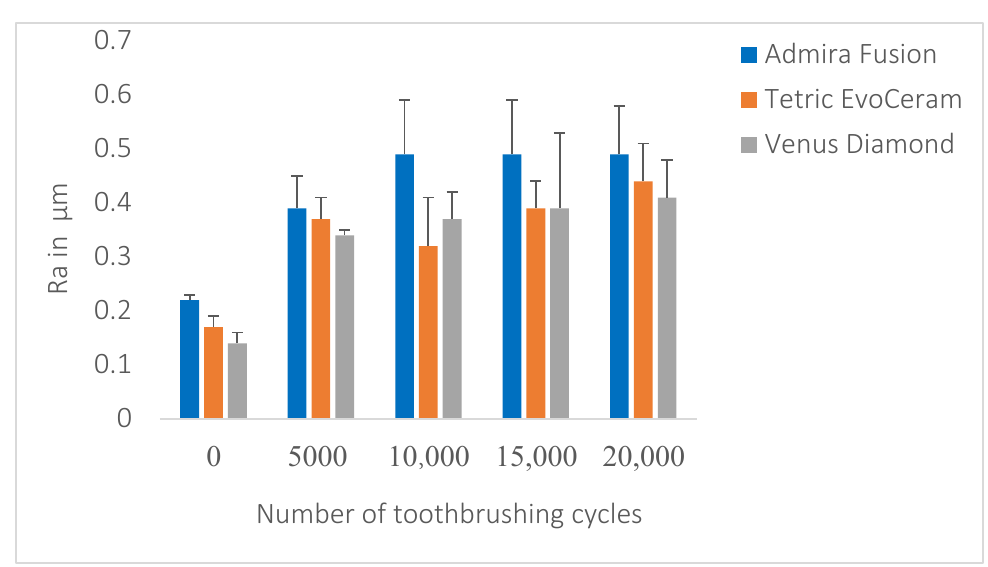
Figure 4. Ra values of the tested composite materials at baseline and after each set of 5000 cycles of toothbrushing abrasion.